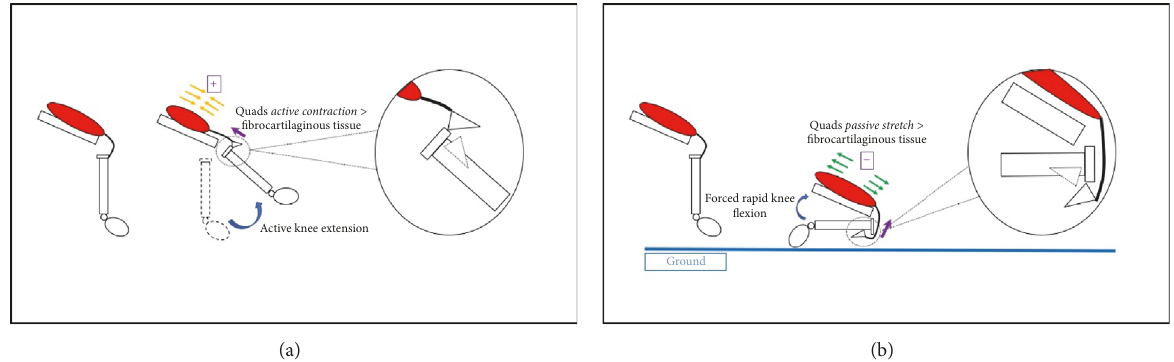
Figure 1: (a) Schematic representation of quadriceps contraction causing proximal tibial avulsion fracture. (b) Schematic representation of forced quadriceps stretch causing proximal tibial avulsion